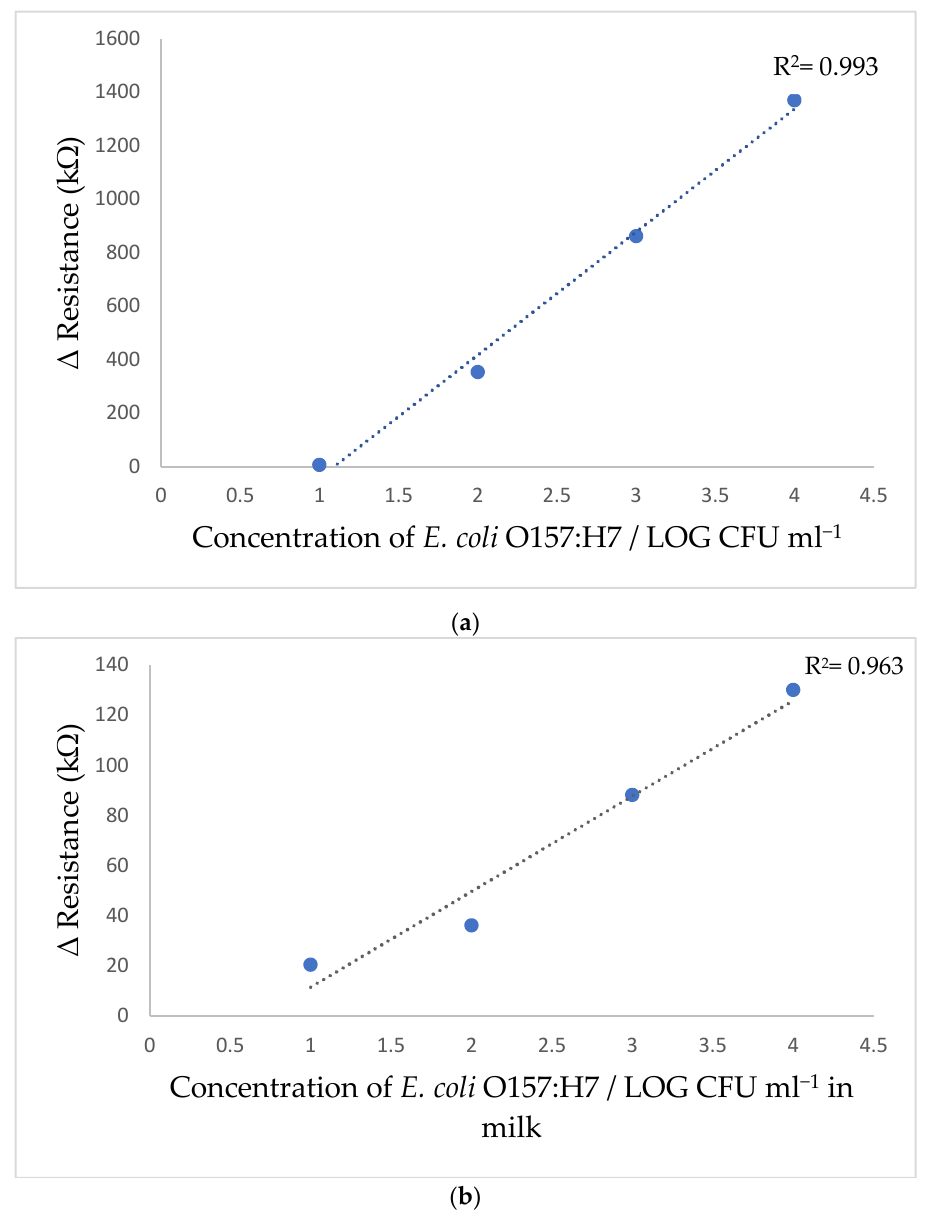
Figure 6. Calibration curve of E. coli O157:H7 sensor in 0.1% peptone water ( a ) E. coli O157:H7 sensor calibration curve in UHT skim milk ( b ).